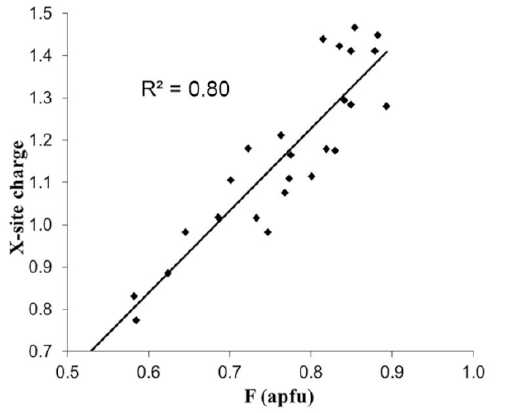
Figure 2. Correlation between the average X-site charge (Na 1 + , Ca 2 + , K 1 + , Pb 2 + ) in Pb-rich tourmalines from the Minh Tien pegmatite, Luc Len district, Vietnam (samples from